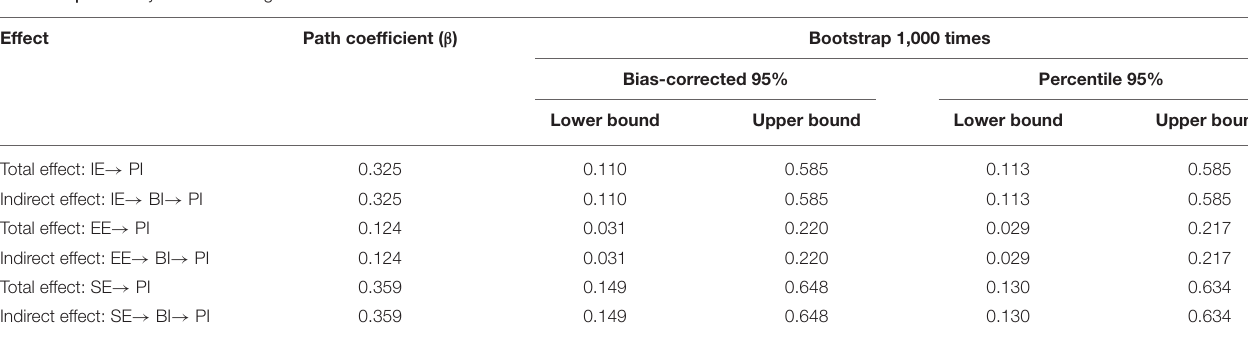
TABLE 5 | The analysis of mediating